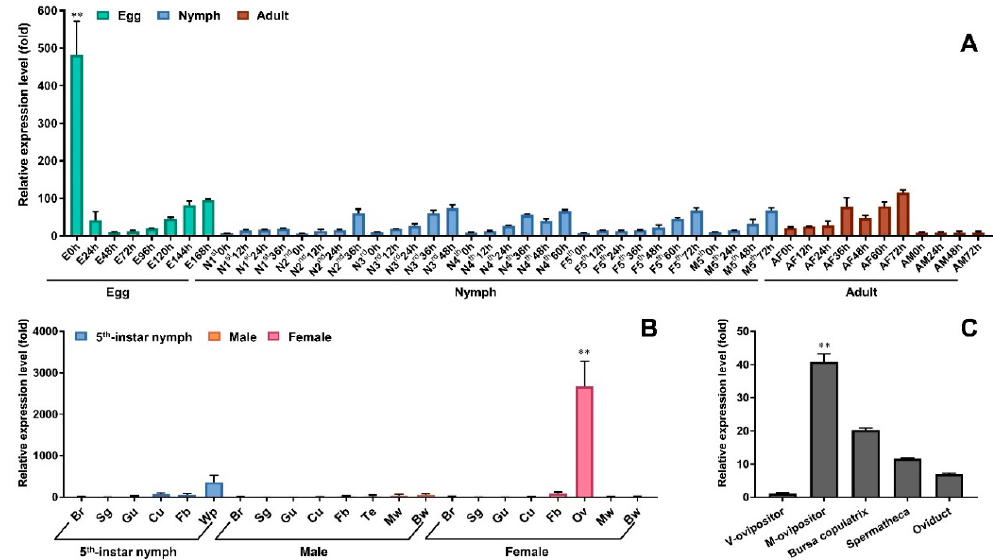
Figure 2. Expression patterns of Nox5 gene in N. lugens by quantitative real-time PCR. ( A ) Developmental expression specificity of Nox5 gene. Total RNAs were extracted from different developmental stages of N. lugens (n = 10–100; namely 100 of the laid eggs at each time point; 20–80 nymphs and 10 adults). E, egg laid in rice leaf sheath; N, nymph; M, male; F, female; A, adult. 1st, 2nd, 3rd, 4th, 5th refer to the 1st-, 2nd-, 3rd-, 4th- and 5th-instar nymphs. ( B ) Tissue expression specificity of Nox5 gene. Total RNA was individually extracted from the brain, salivary gland, gut, cuticle and fat body of 5th-instar N. lugens nymphs, male and female adults (n = 50–100). The wing pad was extracted from 5th-instar nymphs (n = 50); the ovary, testis, macropterous and brachypterous wings (n = 50) were extracted from the female and male adults, respectively. Br, brain; Sg, salivary gland, Gu, gut; Cu, cuticle; Fb, fat body, Wp, wing pad; Te, testis; Ov, ovary, Mw, macropterous wing; Bw, brachypterous wing. ( C ) Ovary-specific expression of Nox5 gene. Total RNA was extracted from the ovipositor, bursa copulatrix, spermatheca and oviduct of female adults (n = 100). M-ovipositor, the ovipositor of female adults mated with males; V-ovipositor, the ovipositor of virgin females. Quantitative real-time PCR was conducted to analyze the Nox5 gene expression change. The relative transcript levels of Nox5 gene in each development stage, each tissue and each part of the ovary were normalized using N. lugens RPS11 , RPS15 and 18S rRNA Ct values as previously described [24]. The reactions were performed with specific primers for amplifying the Nox5 gene. Three biological replications (mean ± SD) were carried out based on the independent RNA sample and the ΔΔ Ct method was used to measure the relative transcript levels in each developmental stage and each tissue. The results of triplicate experiments are shown with standard deviations. p values are indicated (one-way ANOVA by least significant difference-test). Asterisks (**) indicate significant difference ( p < 0.01) in the laid eggs at 0 h from other developmental stages; significant difference ( p < 0.01) in the ovaries of the female adults from other tissues of the 5th instar nymph, male and female adults; significant difference ( p < 0.01) in M-ovipositor from V-ovipositor, bursa copulatrix, spermatheca and oviduct. 3.3. Effect of Nox5 Knockdown on Development of Nymphs To understand whether Nox5 has functional roles during the development process in N. lugens , we conducted phenotypic analysis through the RNAi approach at the in vivo level. Knockdown of Nox5 transcript levels generated lethal defects throughout the nymph and adult stages. The ds Nox5 - treated nymphs showed a deficiency in the molting 3rd–4th-instar, 4th–5th-instar and 5th-instar– adult transitions (Figure 3). By contrast, ds GFP -injected nymphs successfully completed the transitions from nymph–nymph and nymph–adult.